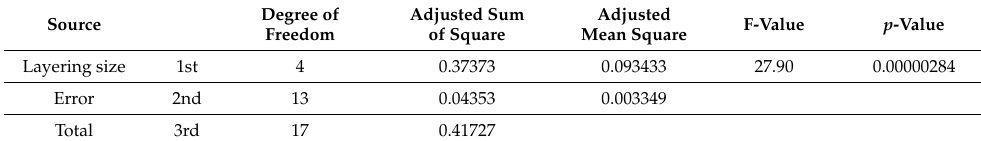
Table 5. Analysis of variance